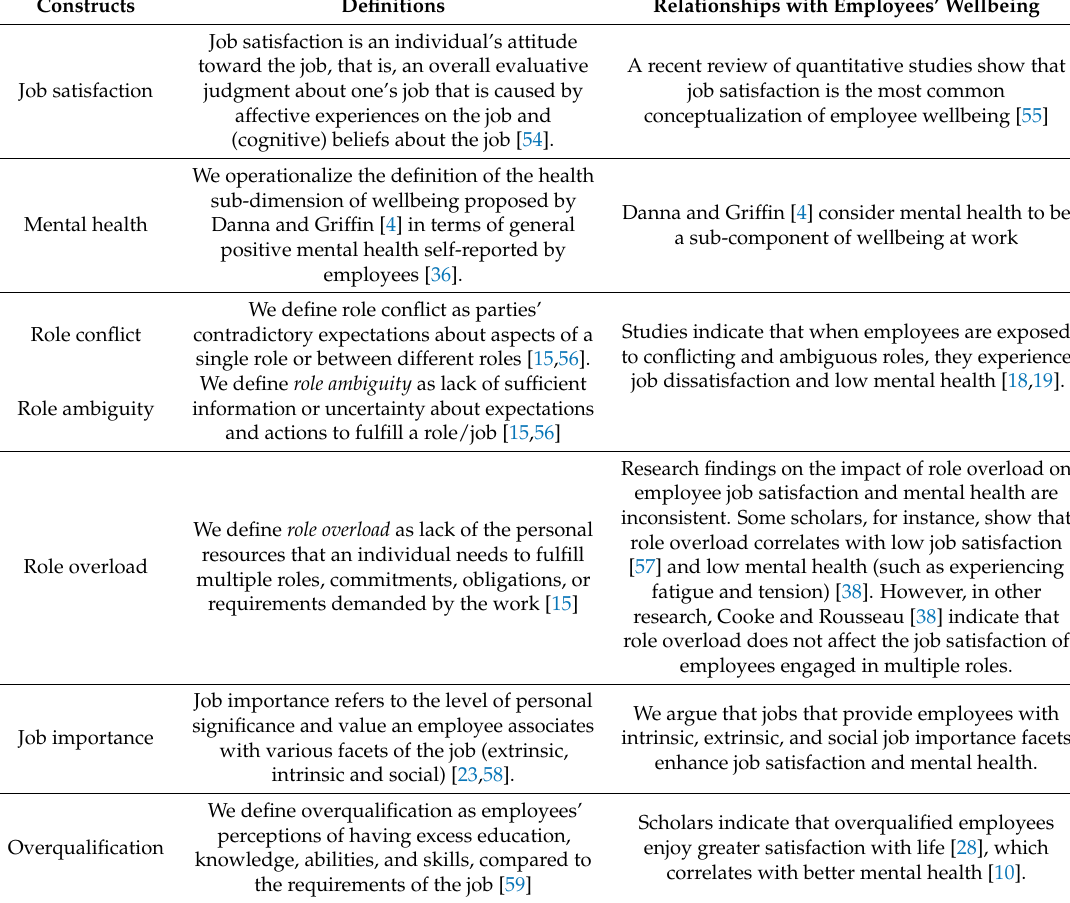
Table A1. Constructs Definitions and their relationship with employees’